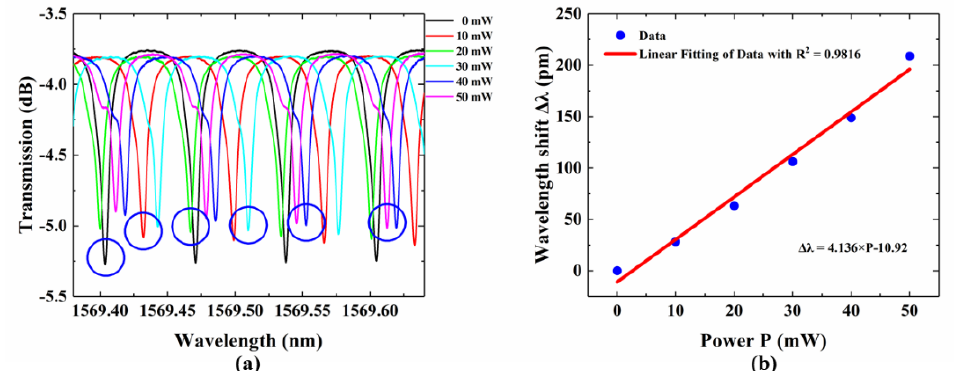
Figure 7. ( a ) Resonant-wavelength tuning of tunable MRR; ( b ) relationship between resonant- wavelength shift and electronic power.